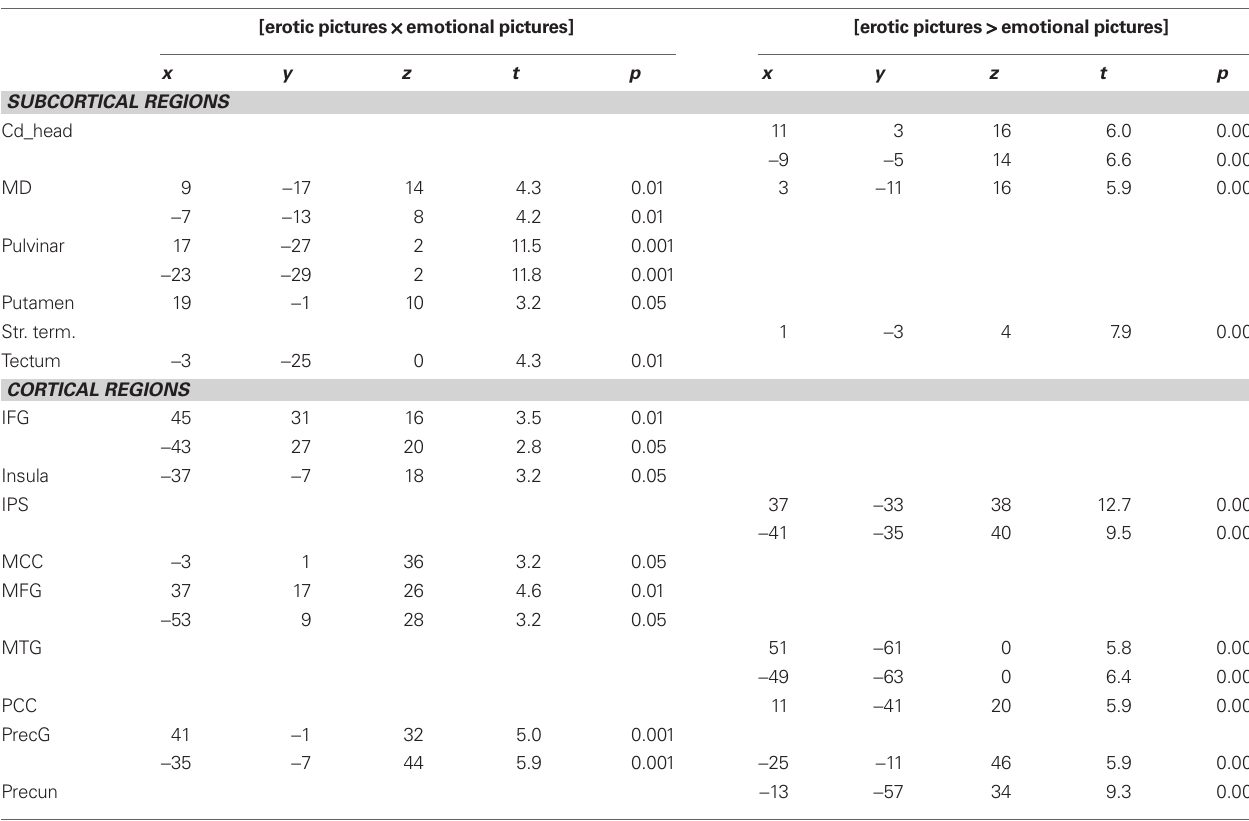
Table 4 | effects of picture